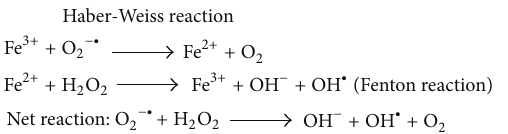
Figure 1: The Haber-Weiss Reaction and Fenton reaction for hydroxyl free radical